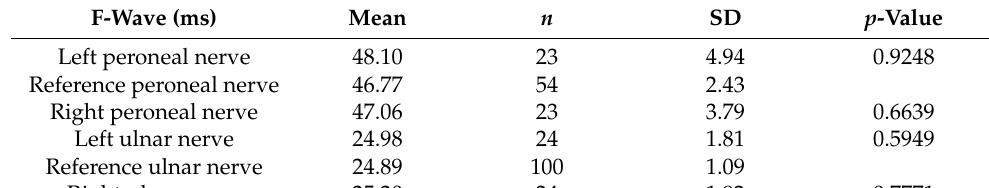
Figure 7. Box-plots for motor neurography F-wave latencies. Filled circles represent values ≥ two standard deviations outside reference values. Table 6. Motor neurography amplitudes for left and right peroneal and ulnar nerve. ** and *** indi- cate statistically significant differences to reference material with p -values corresponding to Bonfer- roni corrected 0.01, and 0.001, respectively.